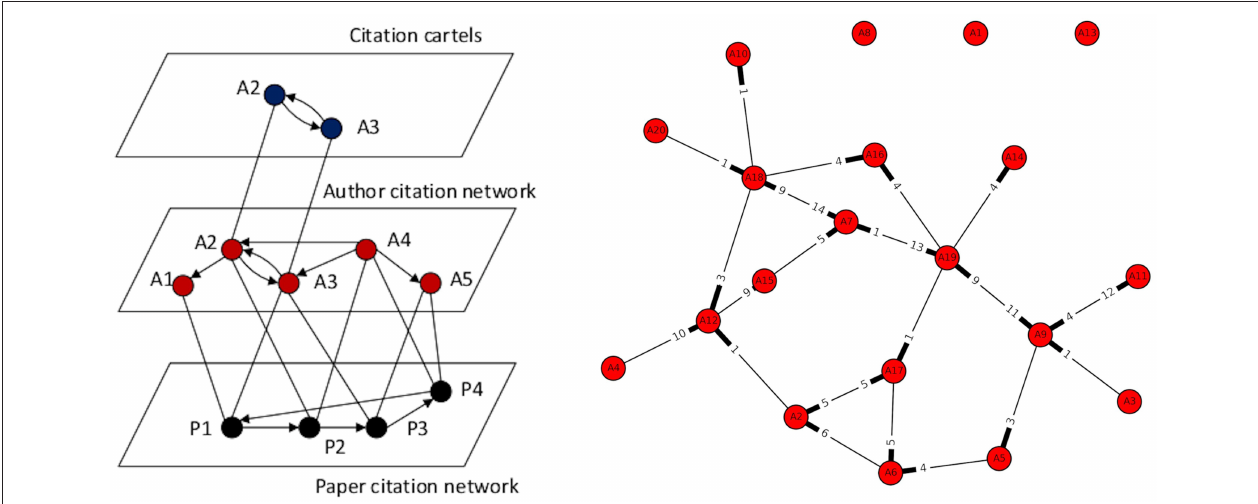
FIGURE 1 | Schematic presentation of citation networks using a multilayer network. The three layers are the paper citation network, the author citation network, and the citation cartel. Relations IsCitedThe (A i ,A j ) ∧ i 6= j are presented by arrows in all three layers. The paper citation and author citation networks are connected over the relation IsAuthorOf (A i ,P j ), while the author citation network and the citation cartel by the relation NumberOfCites (A i ,A j ) ∧ i 6= j . The network on the left shows an example of the randomly generated author citation network. Red colored nodes represent authors (similar as in the main panel), while numbers on the arrows depict the number of cites given by the author. Each edge in this graph represents the relation IsCitedThe (A i ,A j ) ∧ i 6= j